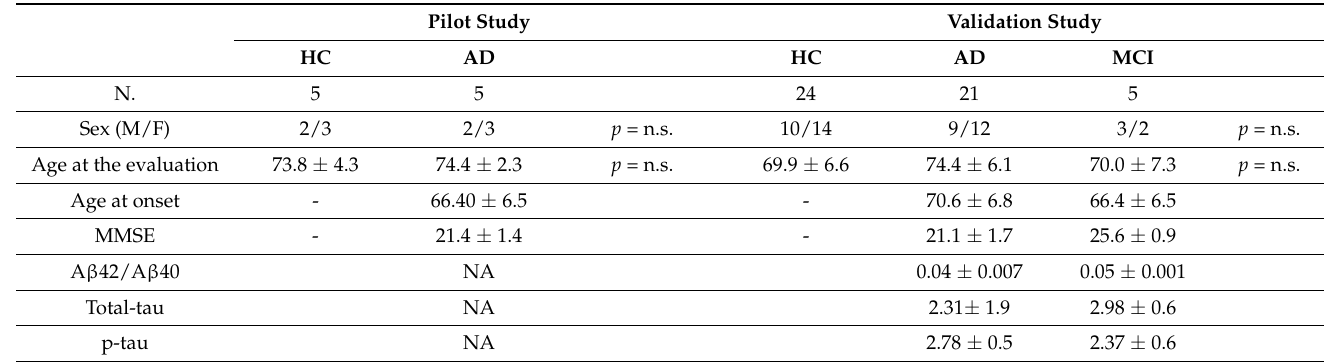
Table 1. Population characterization. All values are expressed as mean ± standard deviation. HC: healthy controls; AD: Alzheimer’s disease; MCI: Mild Cognitive Impairment. MMSE: Mini-Mental